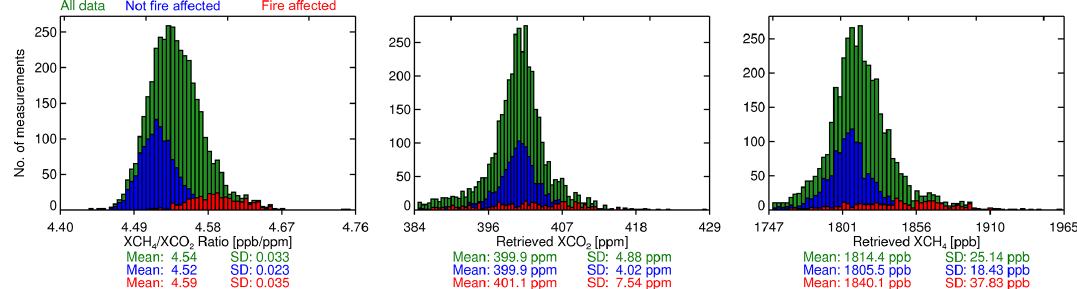
Figure 5. Histograms showing the distributions over Indonesia in September–October 2015 of the XCH 4 / XCO 2 ratio (left), the retrieved XCO 2 (centre) and the retrieved XCH 4 (right) for all data (green), data determined to be definitely affected by fire emissions (red) and those classed as clear (blue). Also included are the corresponding mean and standard deviation values for each